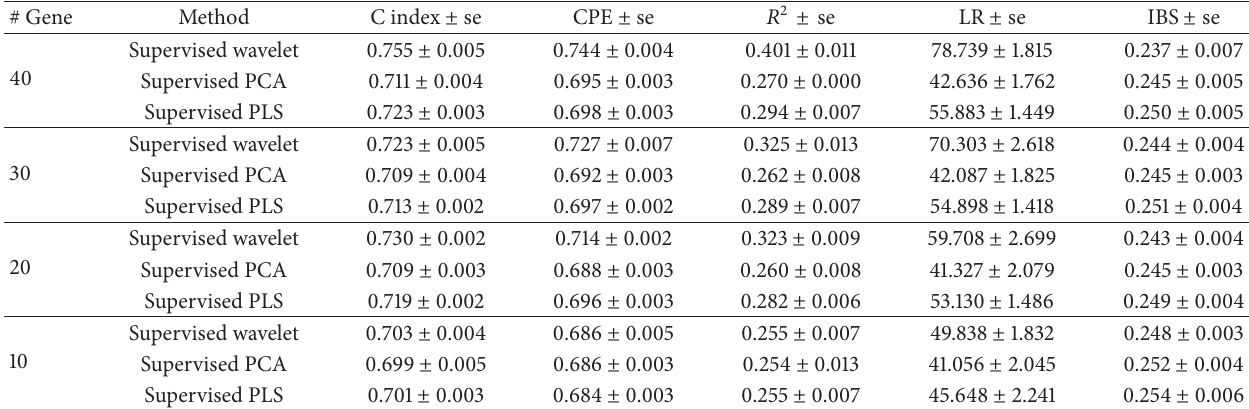
Table 2: Performance of different Cox models for DLBCL dataset.